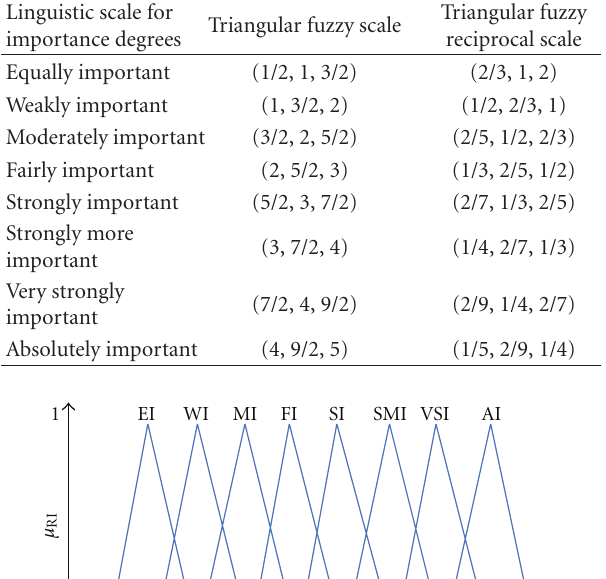
Table 1: Triangular fuzzy conversion scale.